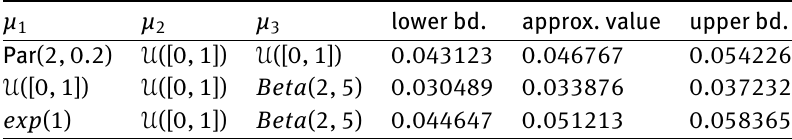
Table 2: Approximation results for inhomogenous marginals, obtained for a discretization of n = 60 sections in each dimen-